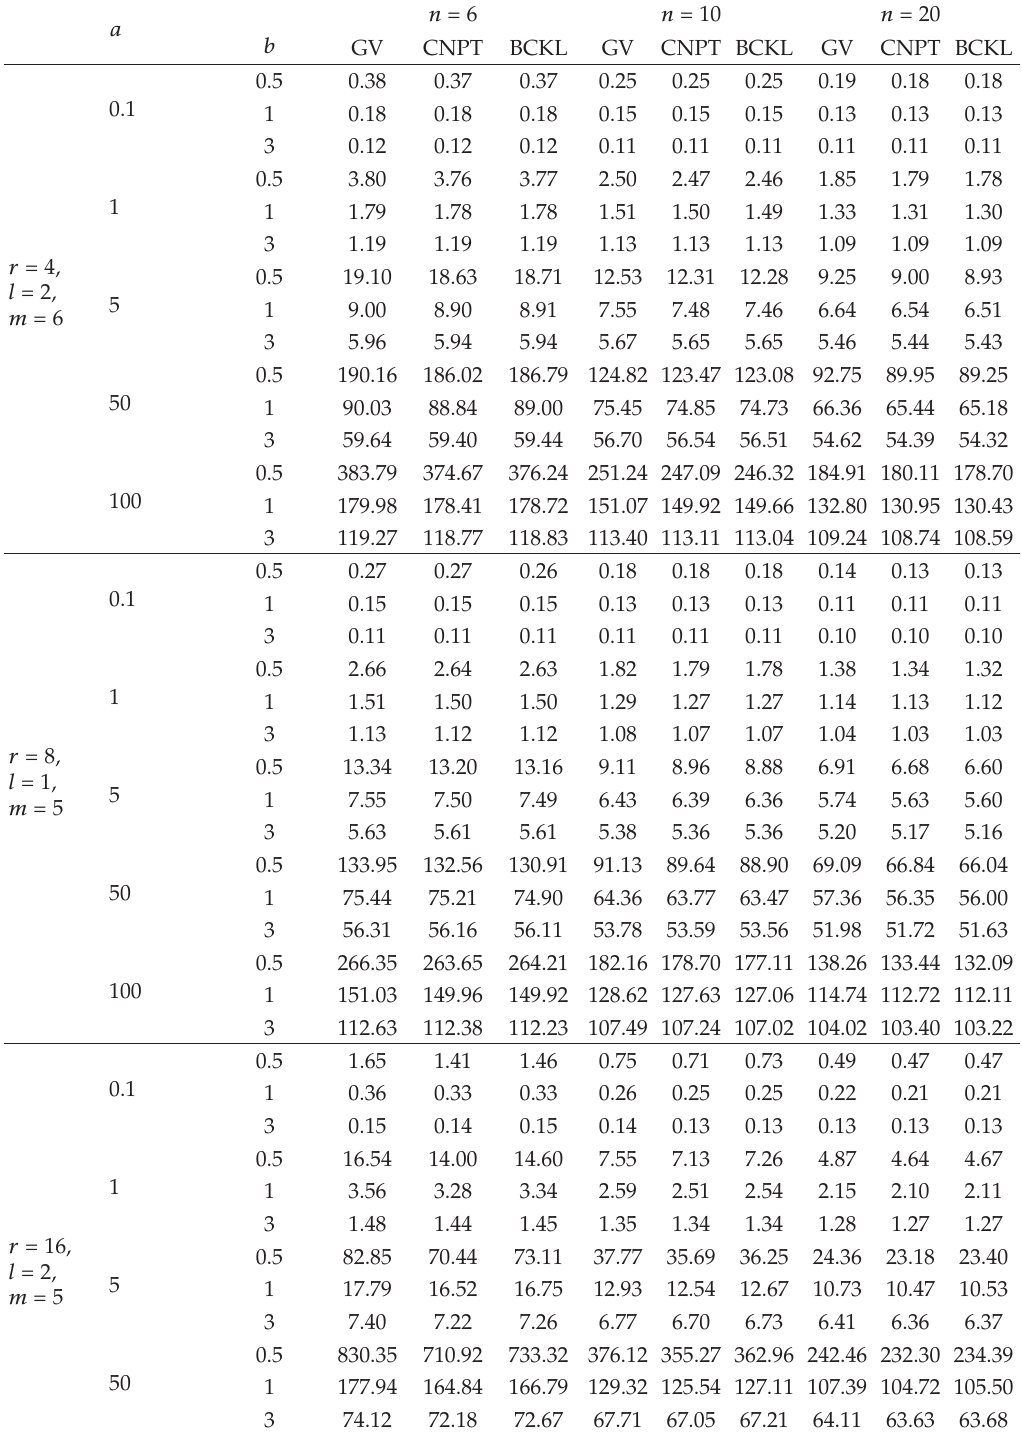
Table 2: Simulated expected lengths of 95% UPL that contain at least l of m future observations at each of r locations from Weibull (cid:3) a, b (cid:4) distribution for sample sizes n (cid:5) 6, 10, 20 using GV, CNPT, and BCKL methods ∗